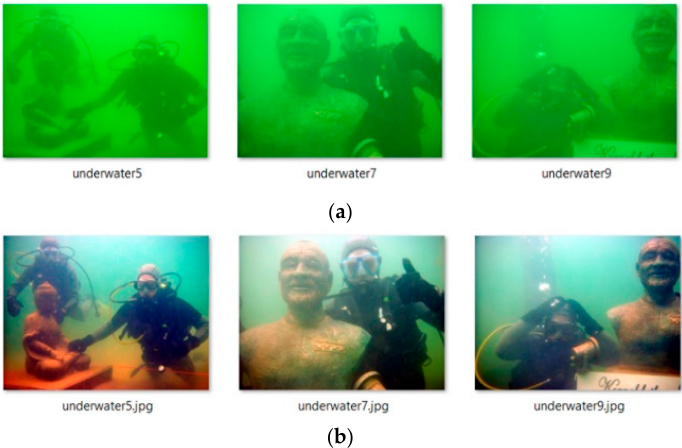
Figure 3. ( a ) Original underwater images processed with ( b ) PA (Source images obtained from